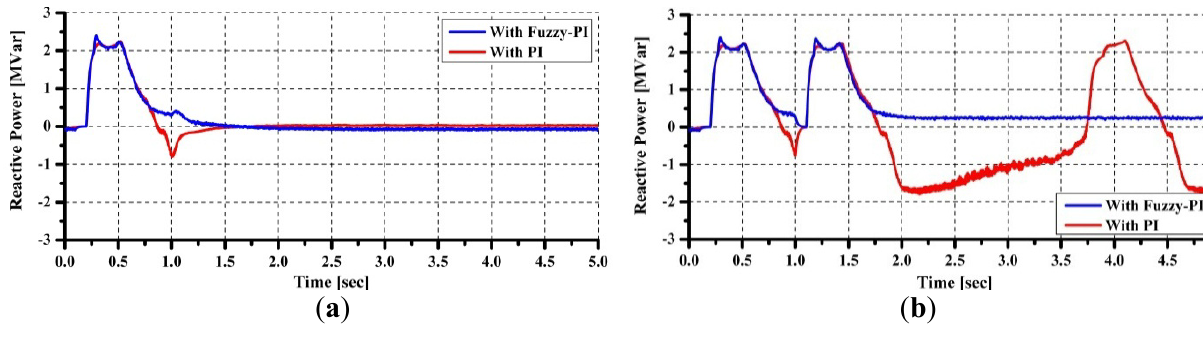
Figure 22. Reactive power output of IG. ( a ) case 1; ( b ) Case